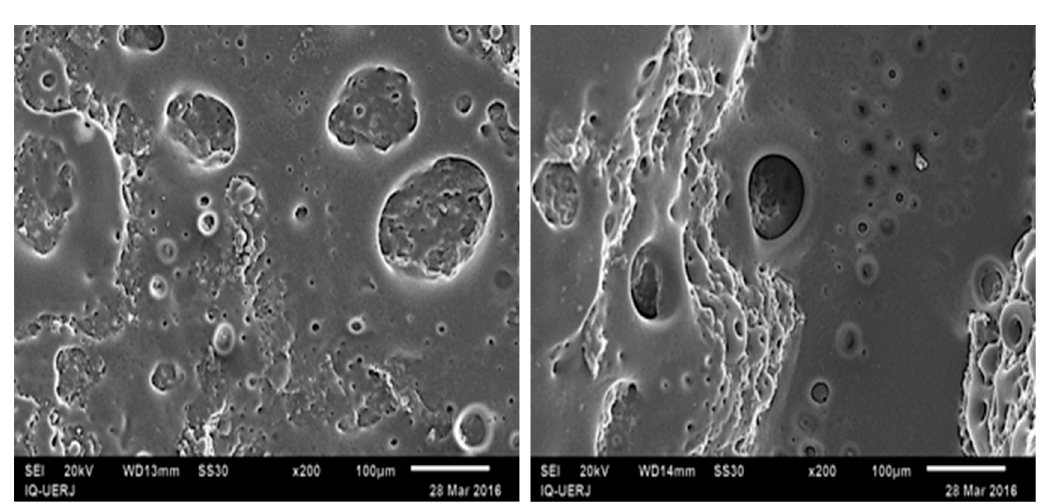
Figure 8. SEM Micrographs of 4:1 PP/HIPS blend with 5 phr of CNSL after acetone extraction of HIPS phase in two different regions of the same sample. Magnification 200×.